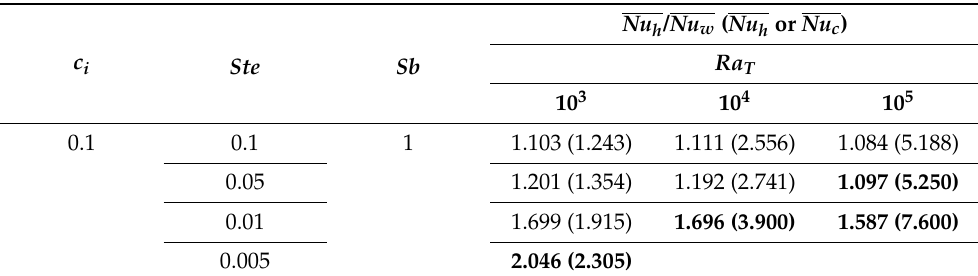
Nu h / Nu w ( Nu h or Nu c ) Ra T 10 3 10 4 10 5